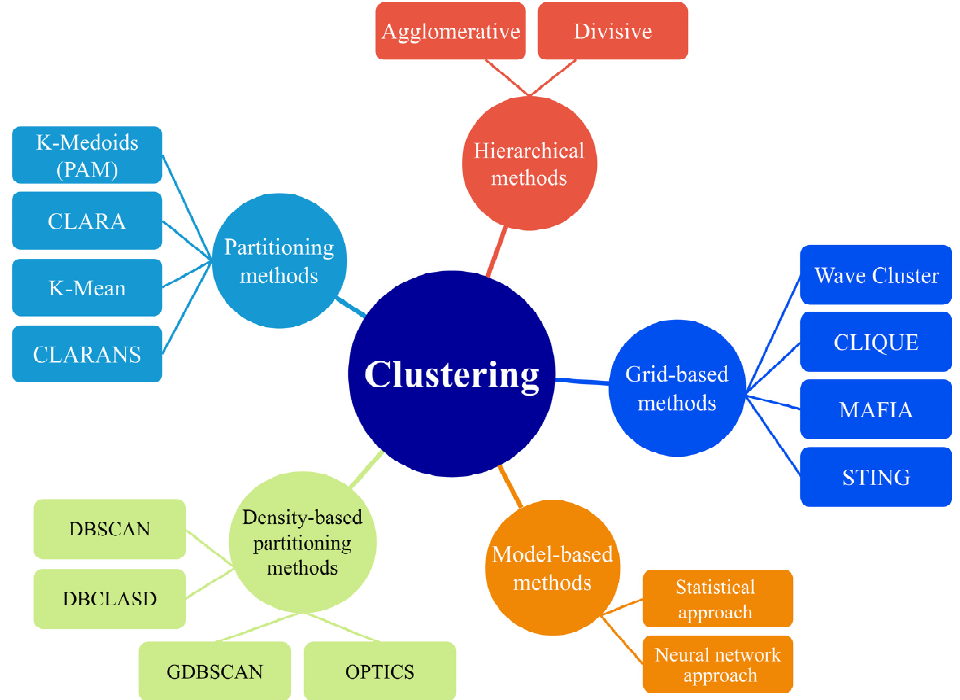
Figure 4. Clustering algorithms organization. Table 5. Common error functions in clustering.